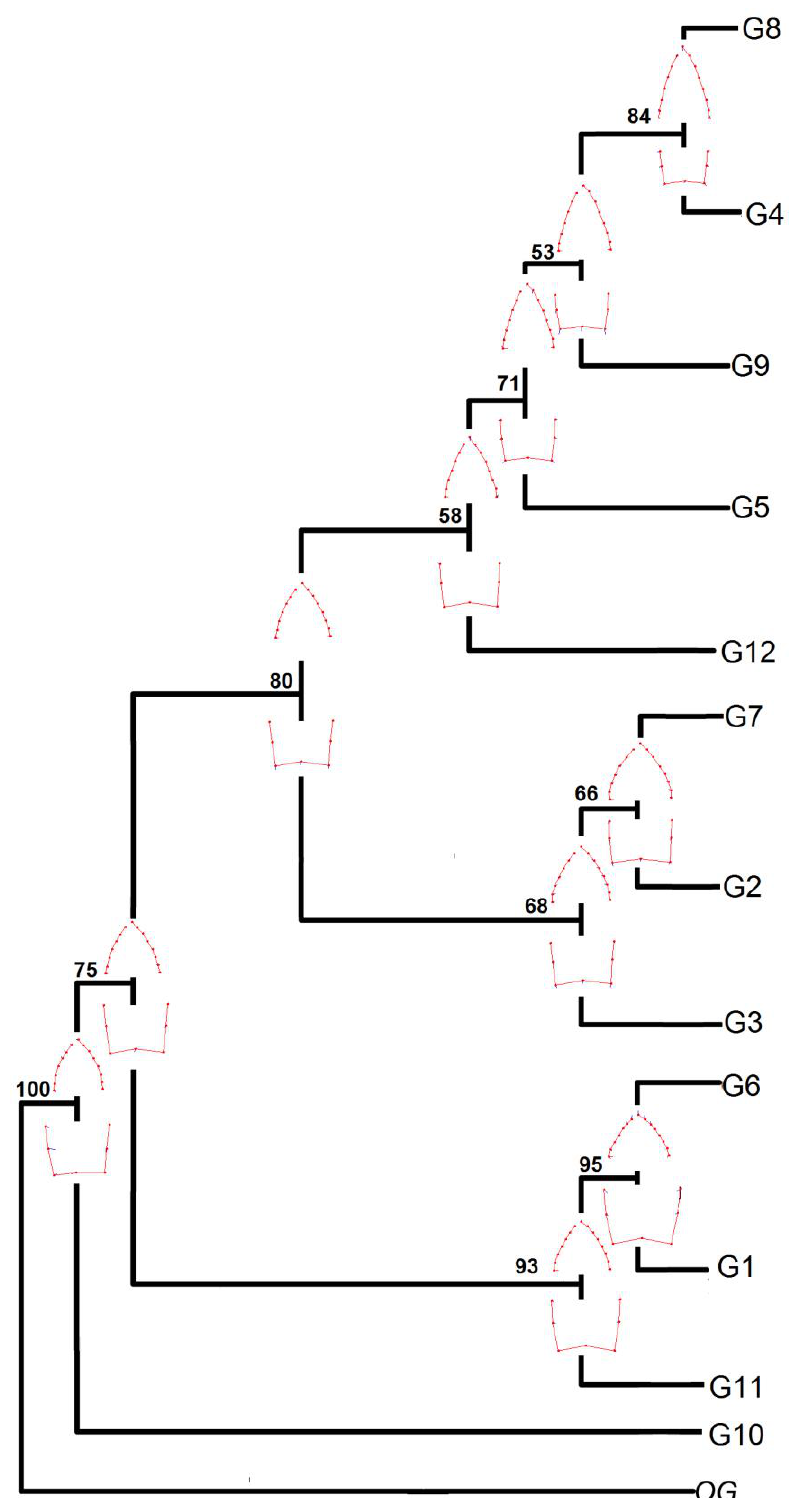
Figure 6. Maximum parsimony tree showing ancestral configuration for blade and stem and the frequency of bootstrap support for each